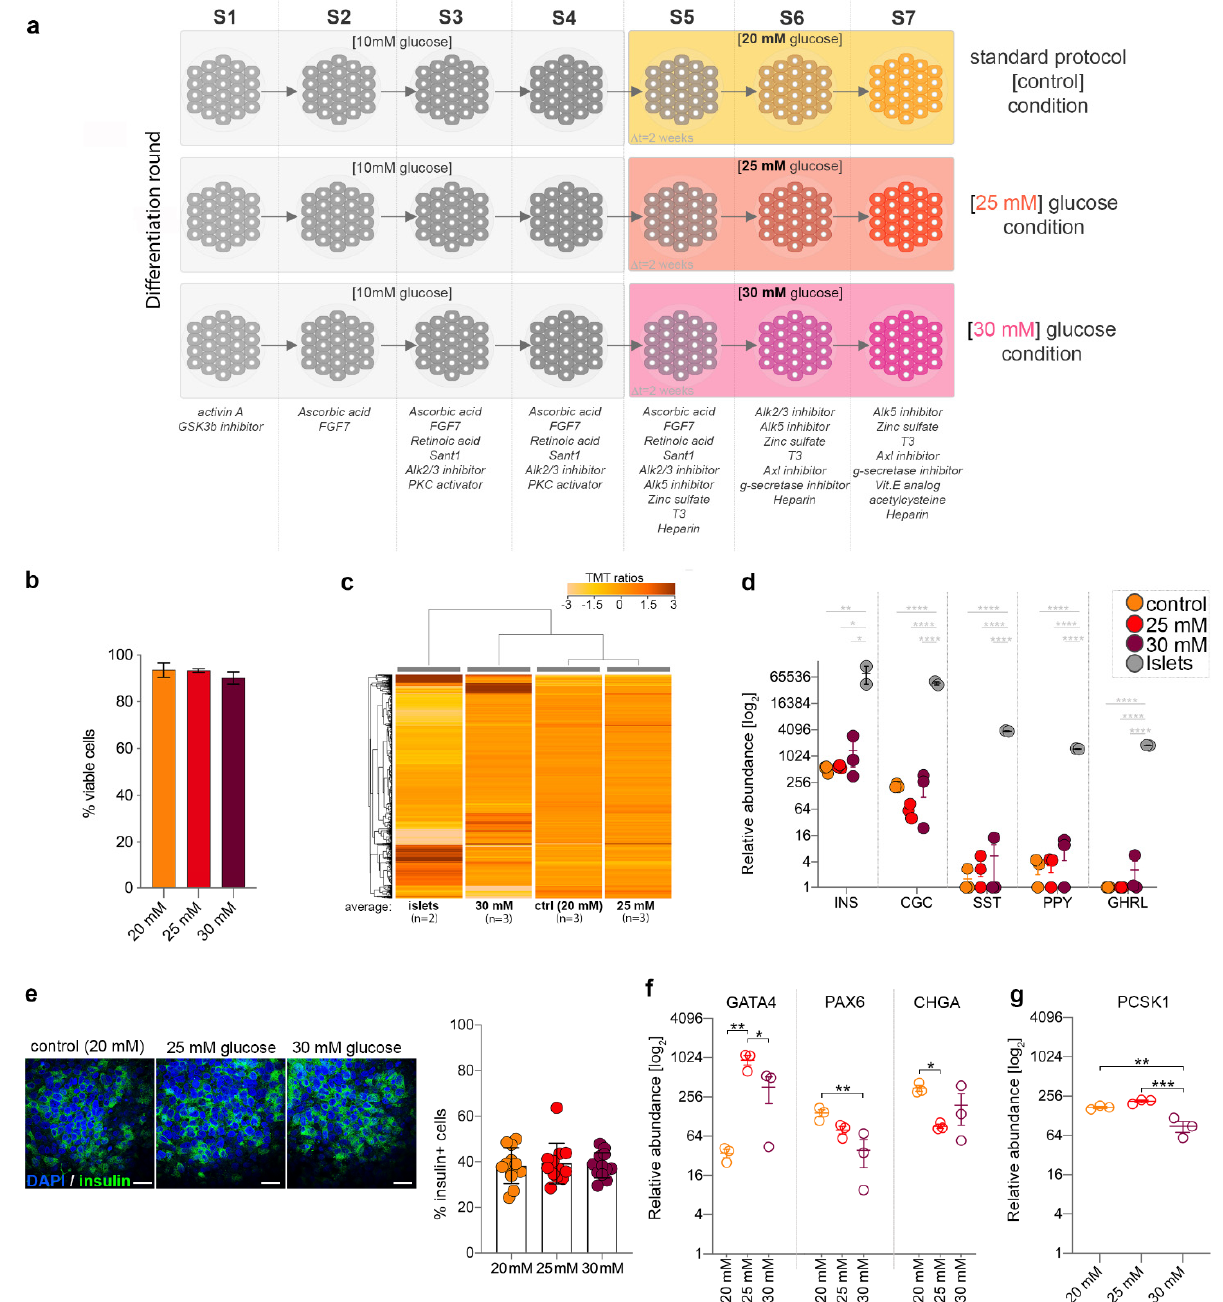
Figure 1. Elevated glucose levels’ effect on key pancreatic islet markers’ abundance. ( a ) Scheme depicting the glucose exposure conditions analyzed. ( b ) Cell viability at the end of stage 7 for the glucose exposure conditions. ( c ) Hierarchical clustering of the average tandem mass tag (TMT) ratios ( n = 2,3,3,3). ( d ) Relative abundance levels of main islet hormones between the compared conditions. ( e ) Confocal imaging and quantification of insulin (Ins) + cells (green) in control (20 mM glucose) and samples exposed to either 25 or 30 mM ectopic glucose (Scale bar: 25 µ m; blue–nuclear staining 4 (cid:48) ,6-diamidino- 2-phenylindole (DAPI). ( f ) Selected markers involved in pancreas development and ( g ) Proprotein convertase 1 (PCSK1) marker in standard (20 mM), 25 and 30 mM glucose conditions. Graphs are shown as mean ± SEM. Statistics: one-way ANOVA with Tukey’s multiple comparisons test. * p < 0.05, ** p < 0.01, *** p < 0.001, **** p <